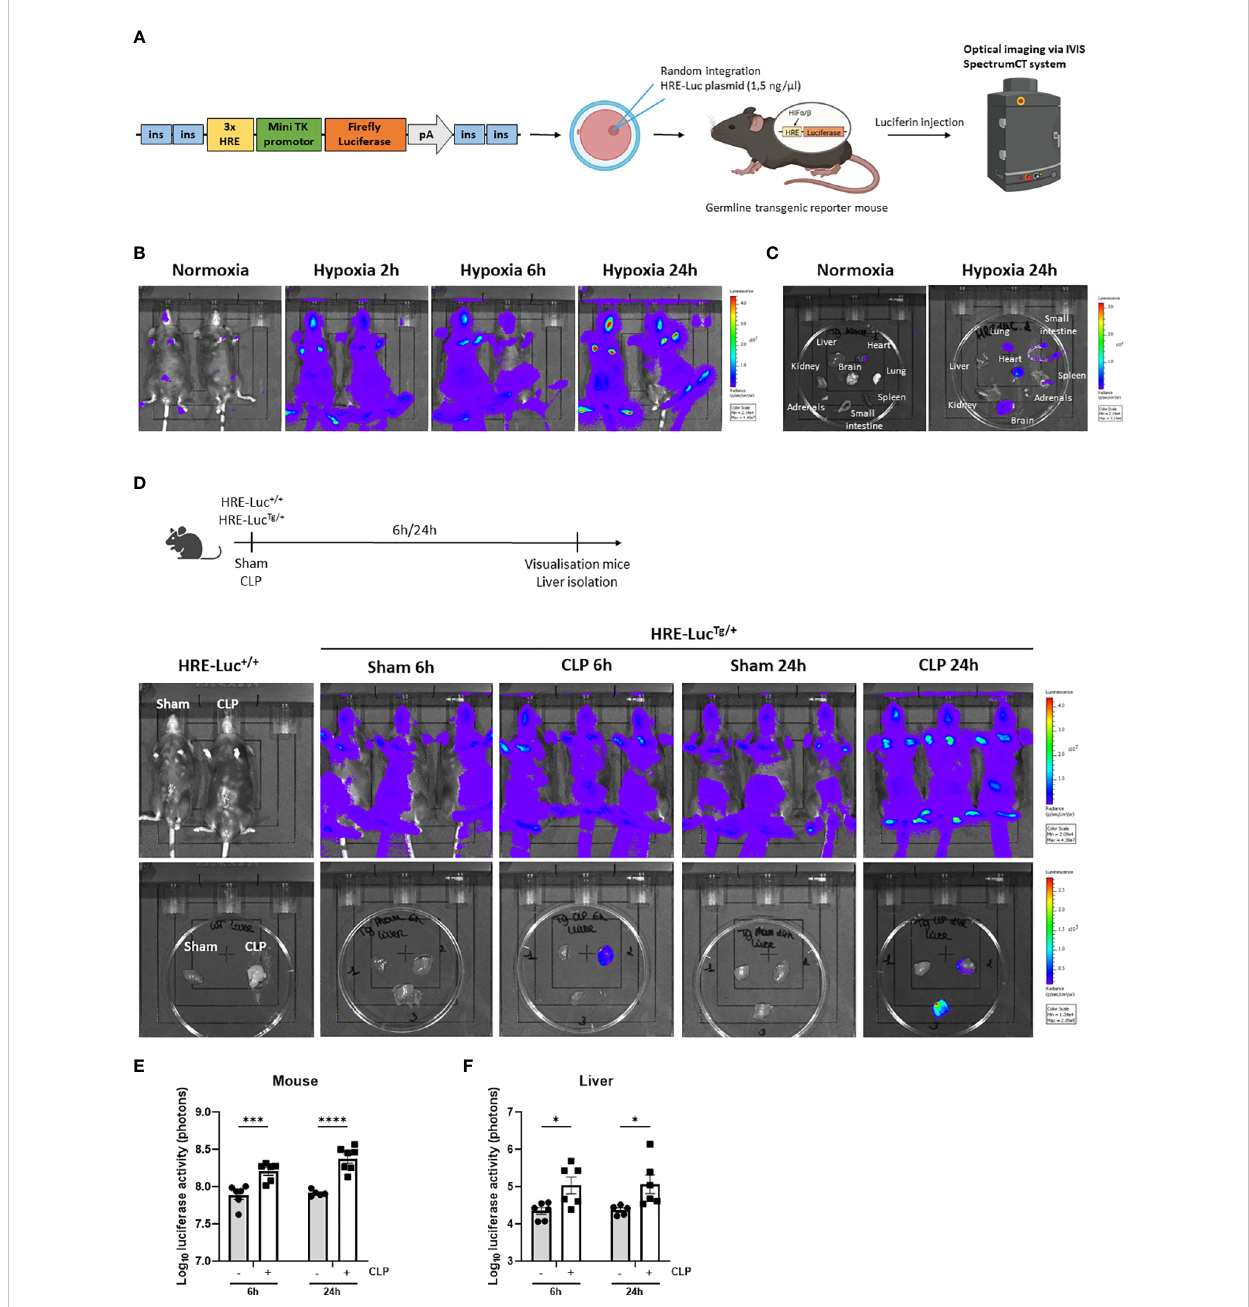
FIGURE 2 HIF activity is detected in the liver of transgenic HIF reporter mice in CLP. (A) A hypoxia reporter plasmid was purchased from Addgene (plasmid #26731). The plasmid contained a cassette containing three Hypoxia Responsive Elements (HRE) derived from the Pgk1 gene (sequence HRE: TGTCACGTCCTGCACGACTCTAGT), followed by a mini TK promoter (27), fi re fl y luciferase cDNA and SV40 polyA was fl anked by 2 chicken beta- globin HS4 insulator core sequences (28) on both sides. The reporter plasmid is reported to be speci fi c for hypoxia signals (27). The puri fi ed fragment (1.5 ng/µl) was injected in C57BL/6J zygotes and randomly integrated. Luciferase activity can be measured via optical imaging using the IVIS SpectrumCT system after i.p. injection of germline transgenic reporter mice and wild-type littermates with luciferin. (B, C) Imaging of the luciferase activity (purple signal) of HRE-Luc Tg/+ mice (B) and their organs (C) in normoxia and hypoxia at indicated timepoints. (D) Experimental set- up and imaging of the luciferase activity of HRE-Luc Tg/+ mice and wild-type littermates and their livers subjected to a sham or CLP procedure at the indicated timepoints. (E, F) Log 10 of the bioluminescent photon counts of HRE-Luc Tg/+ mice (E) and their liver (F) 6h and 24h after sham or CLP (n=6/group). All bars represent mean ± SEM. Each individual data point represents individual mice. P-values were calculated using two-way ANOVA. ****P < 0.0001, ***P < 0.001, *P ≤